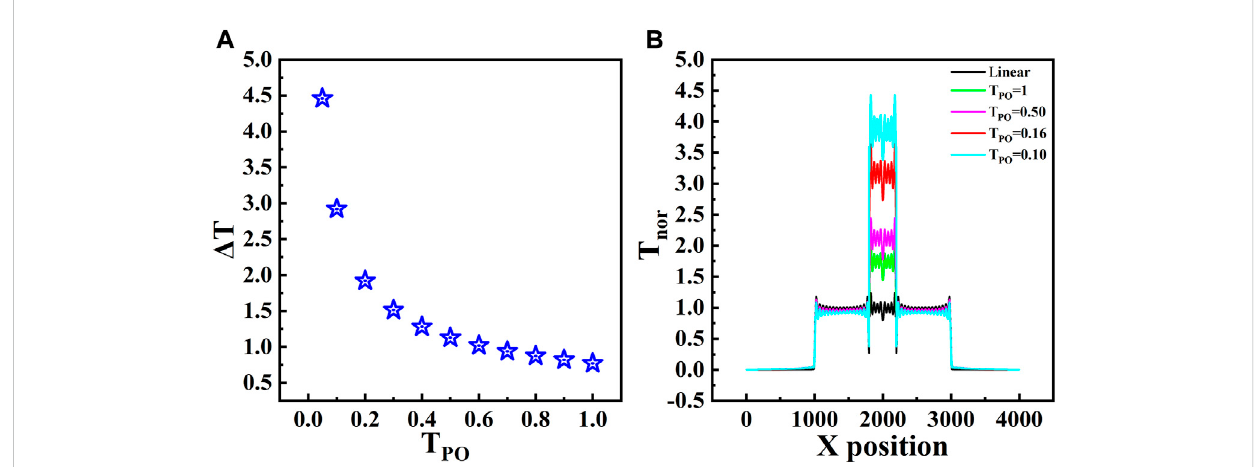
FIGURE 3 (A) Normalized transmittance Δ T as a function of the transmittance of the HPO. (B) The non-linear imaging curve for various transmittance